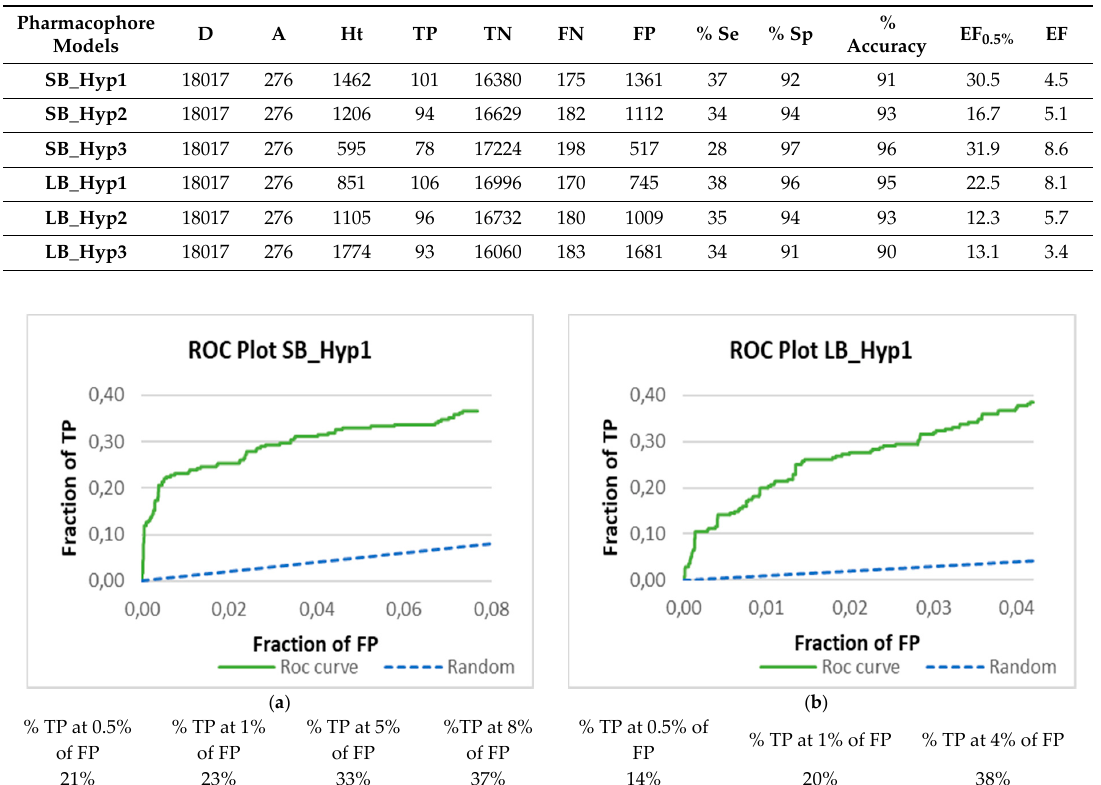
Figure 6. Self-docking validation. Superposition of the best-docked pose of ChEMBL257278 (0.544 Å) (blue) with its crystal structure conformation (yellow). After the docking simulations, the compounds were ranked according to their corresponding docking scores. A cut-off of 55 was applied based on the score range of the 14 BACE1 inhibitors that were docked in the validation process ([121.00–55.74]), and the remaining compounds were